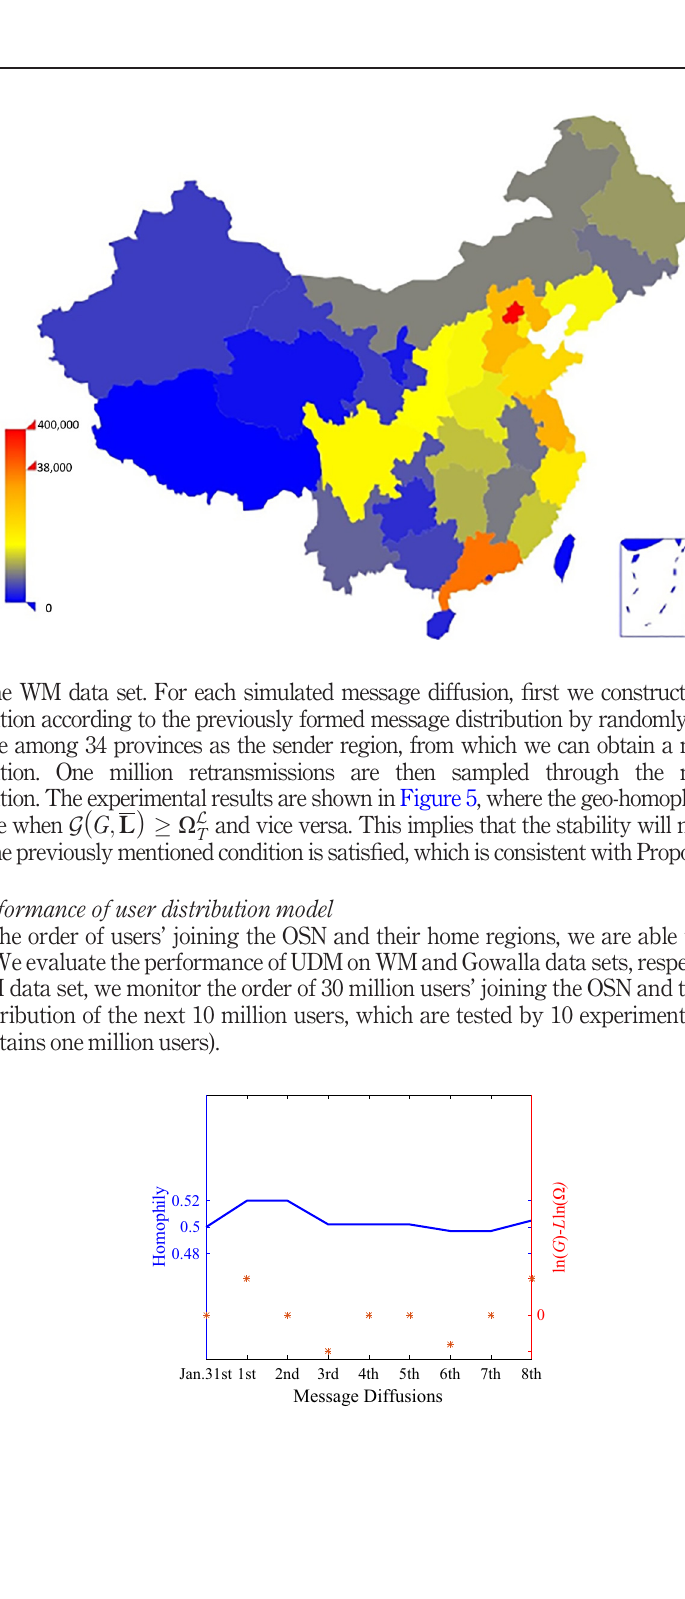
Figure 5. The change of modularity toward information increment Jan.31st 1st 2nd 3rd 4th 5th 6th 7th 8th